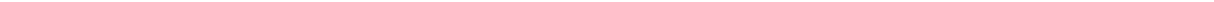
Fig. 1 Comparison and characterization of BC2-nanobody (BC2-Nb) formats for wide- fi eld and dSTORM imaging. a Schematic illustration of the BC2-Nb dye-conjugation strategies. Monovalent and bivalent BC2-Nbs were either conjugated with Alexa Fluor 647 (AF647) via N-hydroxysuccinimide (NHS) ester (left panel) or linked to AF647 by enzymatic sortase coupling (right panel). Wide- fi eld imaging of chemically fi xed HeLa cells expressing mCherry- vimentin BC2T (mCherry-VIM BC2T ) stained with modi fi ed BC2-Nbs. Monovalent versions of the BC2-Nbs (NHS- and sortase-coupled) are depicted on the left panel, corresponding bivBC2-Nbs are displayed on the right side. Stainings with NHS-conjugated nanobodies are shown in two different image contrasts, the upper half in the same brightness and contrast as the sortase-coupled nanobodies; in the lower half with an adjusted contrast. Scale bars, 25 µ m. b Representative dSTORM images of chemically fi xed HeLa cells expressing vimentin BC2T , stained with the monomeric NHS-conjugated BC2-Nb AF647 µ m, insets 1 µ m. Image reconstruction details are given in Methods (NHS) (left) and the sortase-coupled bivBC2-Nb AF647 (sort) (right). Scale bars, images 5 section. c Assessment of staining quality in wide- fi eld fl uorescence imaging. Labeling of the different nanobody formats was quanti fi ed by calculating the ratio of the signal intensity of mCherry-VIM BC2T expressing cells to non-transfected cells (background), (BC2-Nb AF647 (NHS) : n = 115; bivBC2-Nb AF647 (NHS) : n = 134; BC2-Nb n = 150; bivBC2-Nb n = 195) (Methods section, Supplementary Fig. 1). d Assessment of bivBC2-Nb AF647 (sort) : AF647 (sort) : AF647 staining of endogenous β -catenin. Bar chart summarizes measured nanobody per µ m 2 values for untransfected chemically fi xed HeLa cells stained with GFP-Nb AF647 or bivBC2-Nb AF647 in comparison to chemically fi xed HeLa cells transiently expressing BC2T LC3B stained with bivBC2-Nb AF647 , errors given as standard deviation (S.D.), N = 3 cells for each condition (Methods section, Supplementary Fig. 2). e Quanti fi cation of completeness of labeling for the bivBC2-Nb and SNAP-tag labeling systems using FtnA-oligomers of 24 subunits. Bar chart summarizes median values of FtnA-24mer fl uorescence intensities as percentage of theoretical maxima (Methods section, Supplementary Fig.